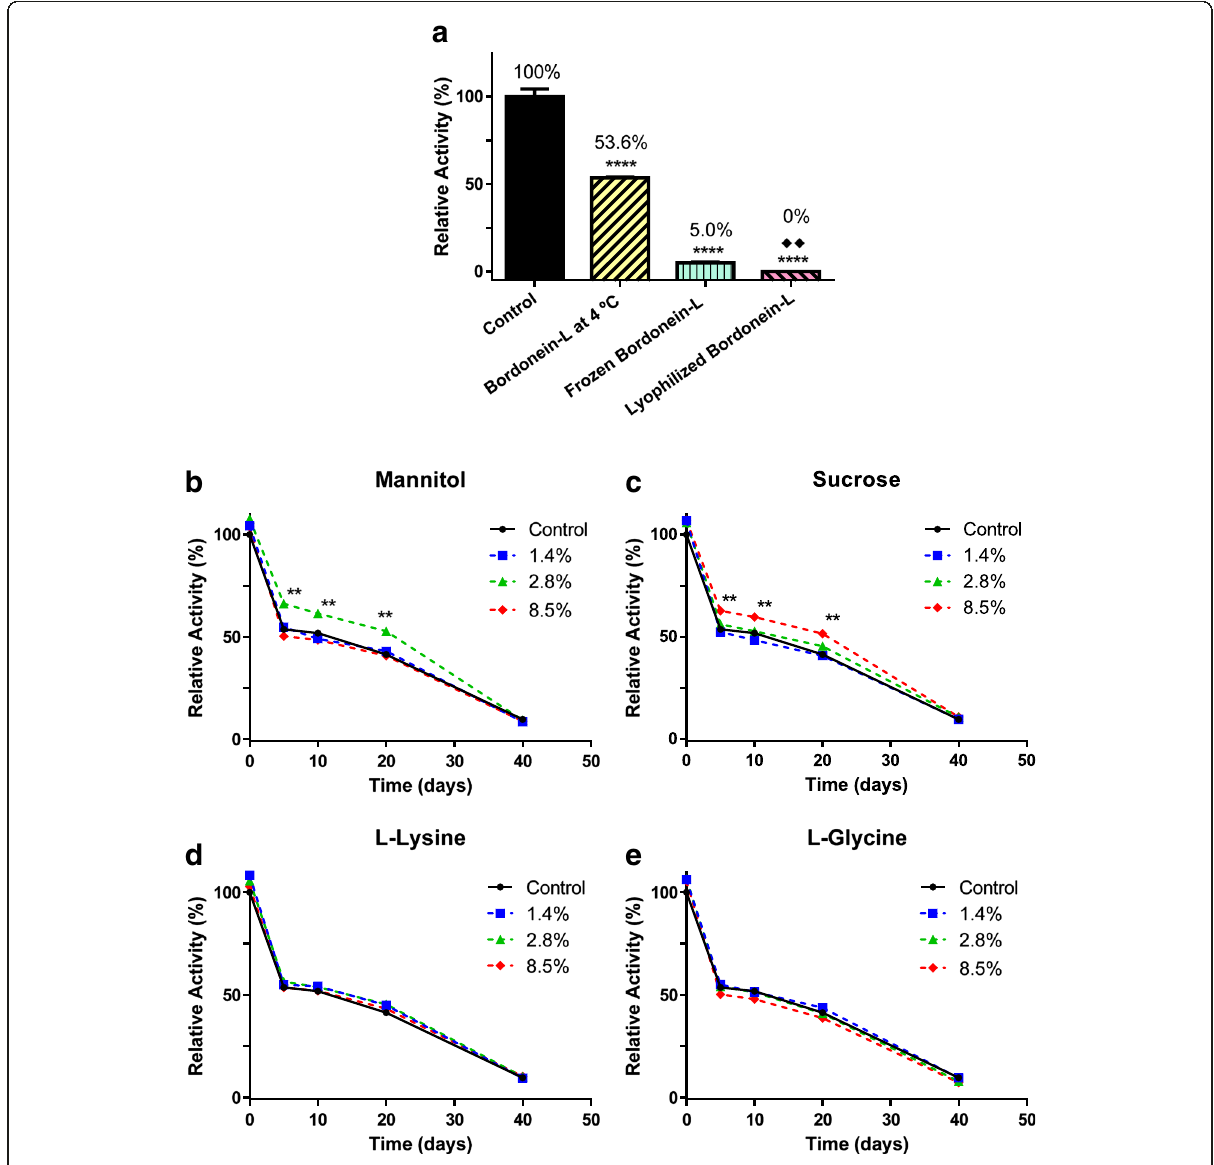
Fig. 5 Bordonein-L stability. a Evaluation of stability after five days at − 20 °C and 4 °C and as soon as the lyophilization was finished. The stability was also evaluated for 40 days in the presence of ( b ) mannitol, ( c ) sucrose, ( d ) L-lysine and ( e ) L-glycine. All samples were kept protected from light. Each point represents the mean±S.E.M. ( n =3) at each additive concentration (** p <0.0001 compared to the respective control using one-way ANOVA test). Each bar represents the mean±S.E.M. ( n =3) at 4 °C, freezing and lyophilization conditions (**** p <0.0001 when 4 °C, freezing and lyophilization was compared to control and when freezing and lyophilization compared to 4 °C using one-way ANOVA test; ♦♦ p <0.05 when freezing and lyophilization were compared to each other using the t